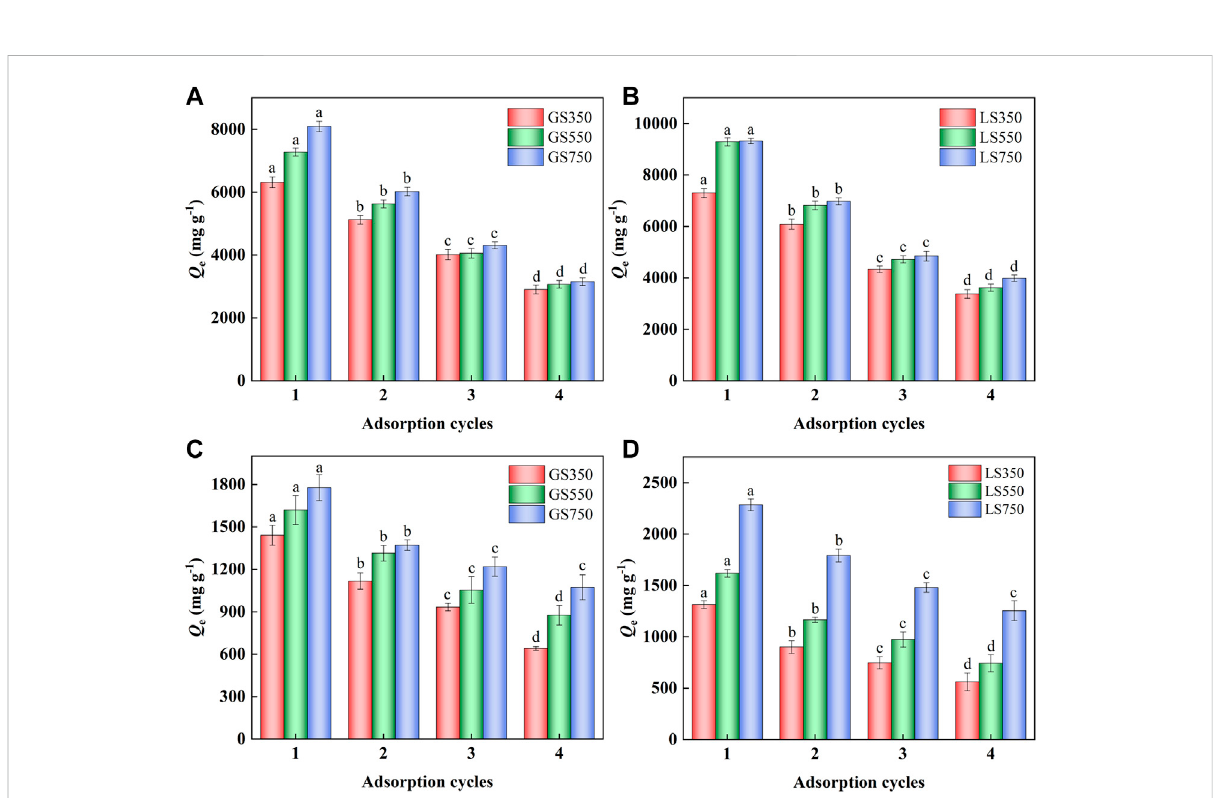
Reabsorption experiments of MG (A,B) and ST (C,D) sorption onto GSBC and LSBC. For MG and ST, initial pH of 8 and 4, respectively, initial concentration of 3,500 mg L − 1 , 24 h. The error bars represent the standard deviation of the mean values. The different letters above the histogram indicate signi fi cant differences at p < 0.05 (ANOVA and Duncan ’ s multiple range test using SPSS